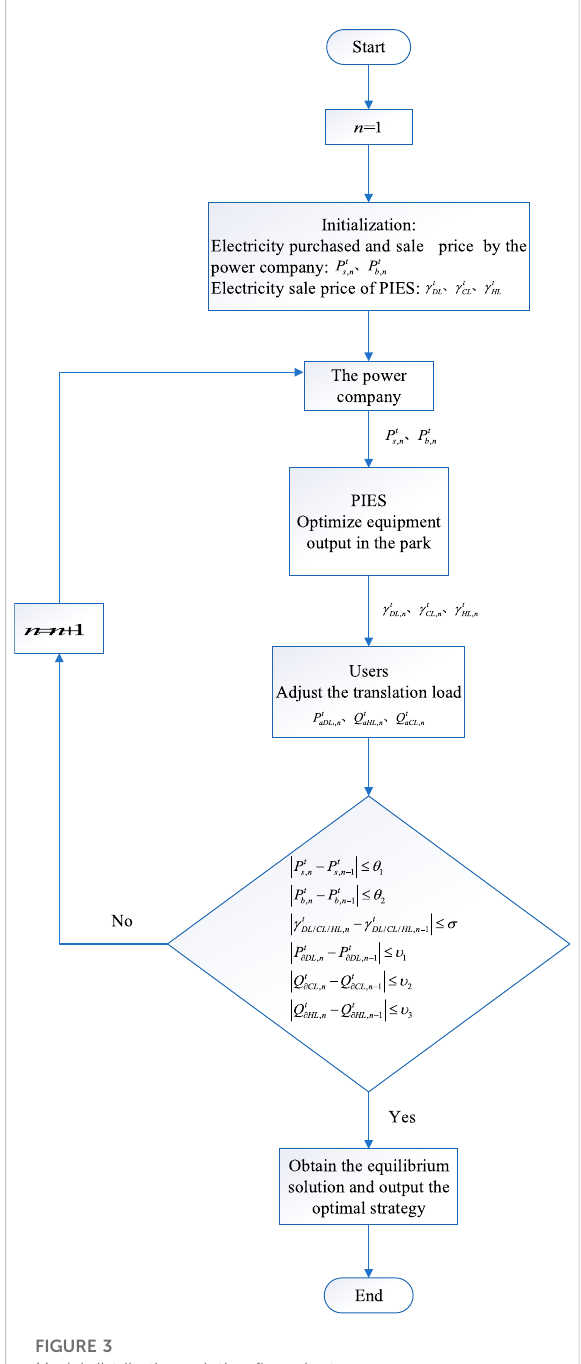
FIGURE 3 Model distribution solution fl ow